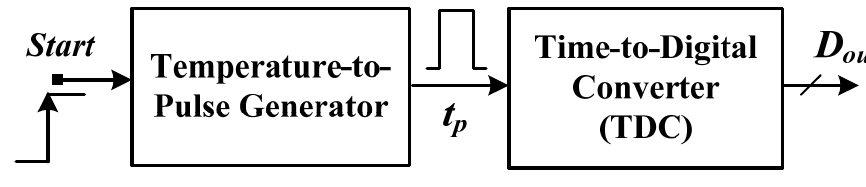
Figure 1. Block diagram of the time-domain smart temperature sensor